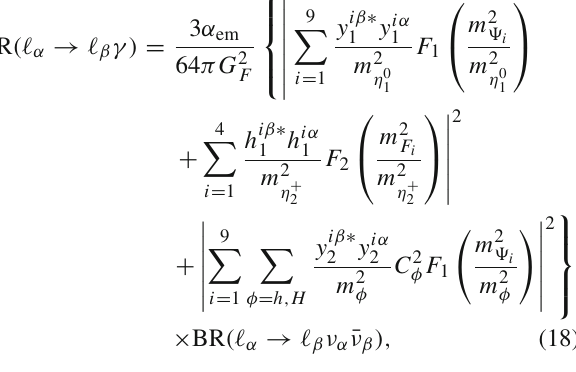
Fig. 2 Dirac neutrino mass